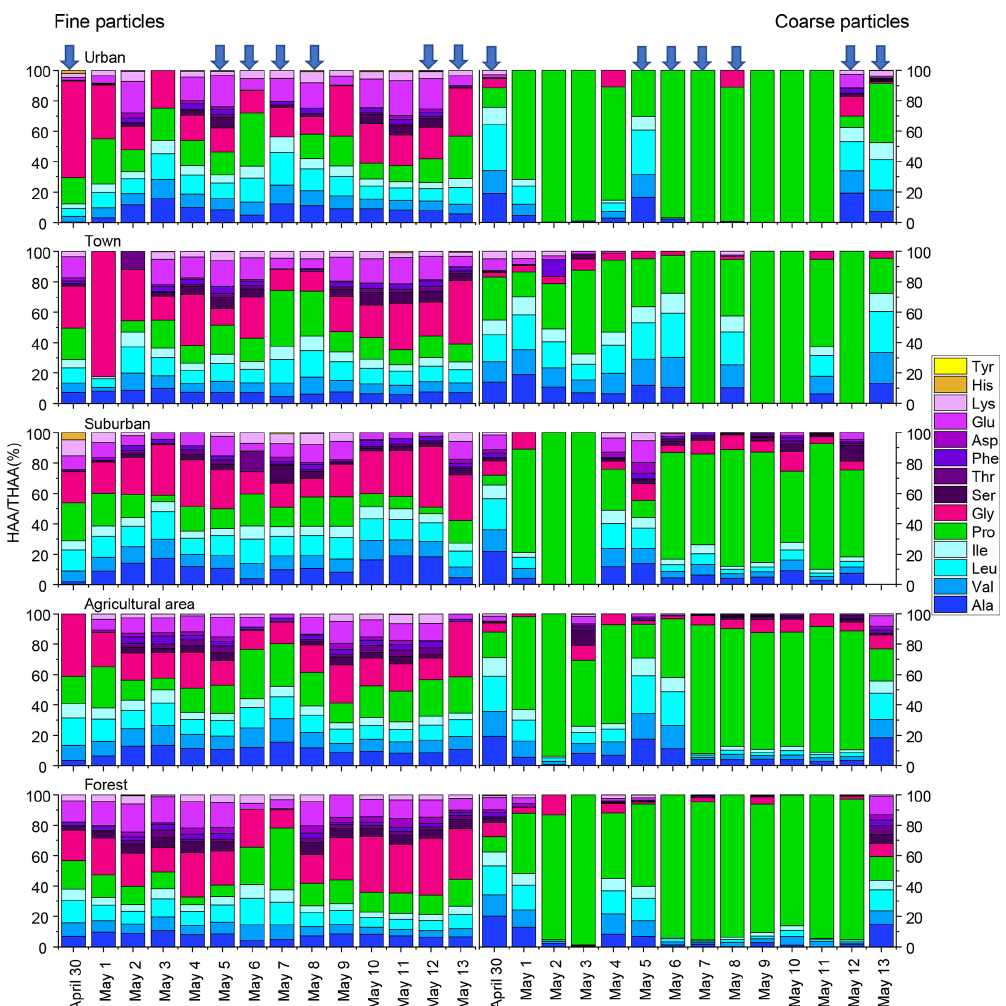
Figure 2. Percentage composition of each hydrolyzed amino acid (% of THAA) for fine and coarse aerosol particles in urban, town, suburban, agricultural and forest sites during 14 consecutive sampling days. The blue arrow represent